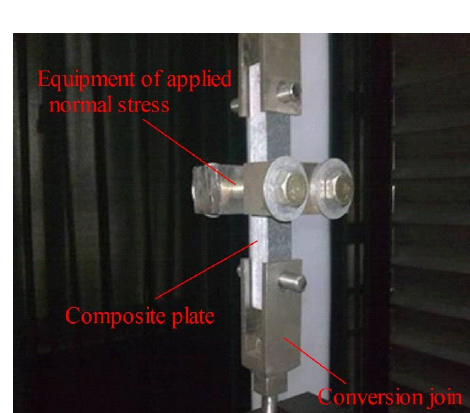
increased, the ultimate load of the experiment specimen continued to